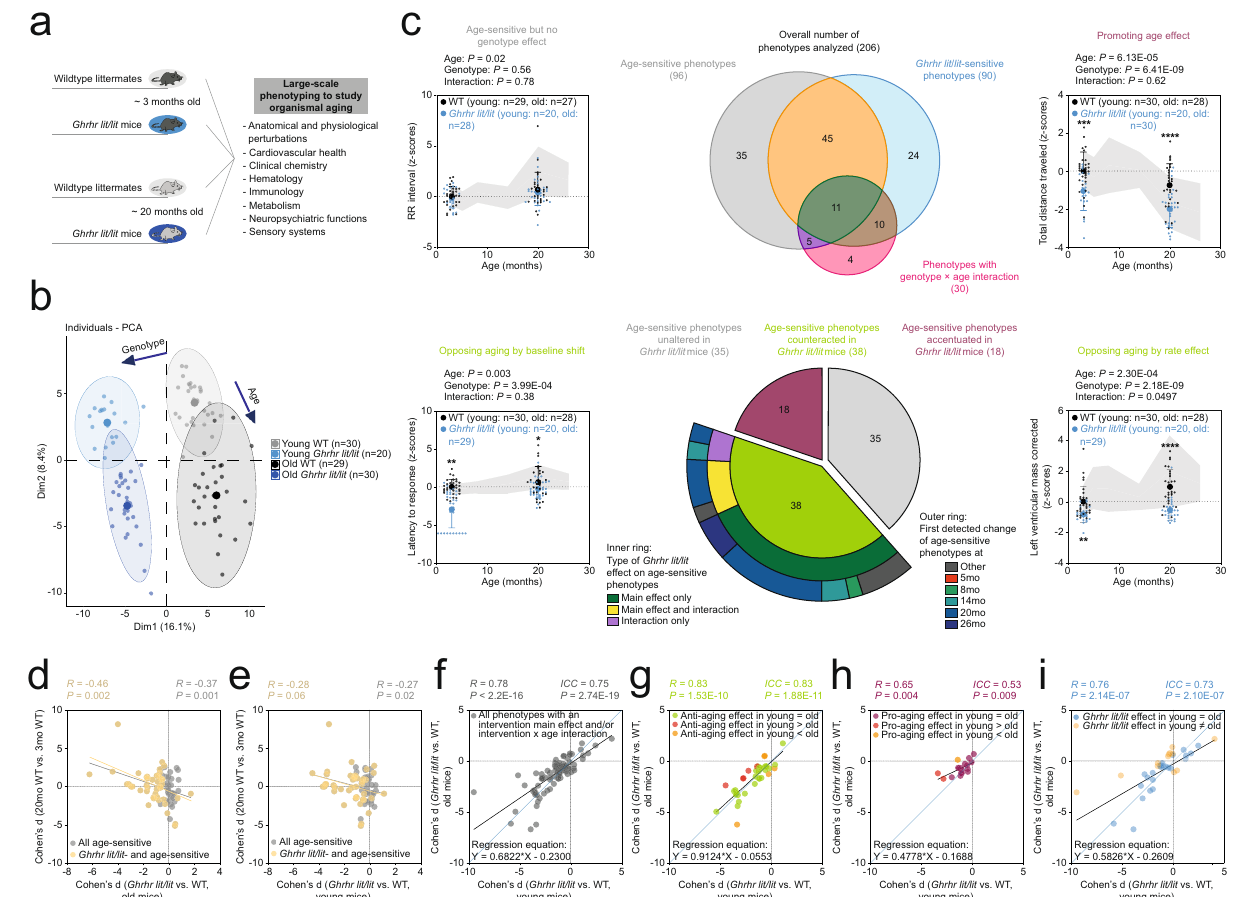
Fig.3| ‘ Anti-aging ’ effectsinducedbythe Ghrhr lit/lit mutationmanifestedmostly in young mice (prior to detectable age-dependent phenotypic changes). a – i Deep phenotyping results in Ghrhr lit/lit mice. a Schematic illustration of study design. Mouse symbols adapted from ref. 10. b Principal component analysis of deep phenotyping data. c Venn diagram shows the number of ASPs, genotype- sensitive phenotypes, phenotypes with a genotype×age interaction and their intersection. Sunburst chart shows the number of ASPs either unaltered, counter- acted or accentuated by genotype. For ASPs counteracted by genotype, the inner ring shows the proportion of phenotypes with either a genotype main effect, a genotype×age interaction or both. The outer ring shows when changes in the corresponding ASPs were fi rst detected in our baseline study. Line charts show representative examples of phenotypes in fl uenced by age and/or intervention in the different possible ways. Data are presented as z-scores (normalized to the young WT group) and are plotted as mean+/ − S.D. (individual data points are superimposed). Two-way ANOVAs with the between-subjects factors age